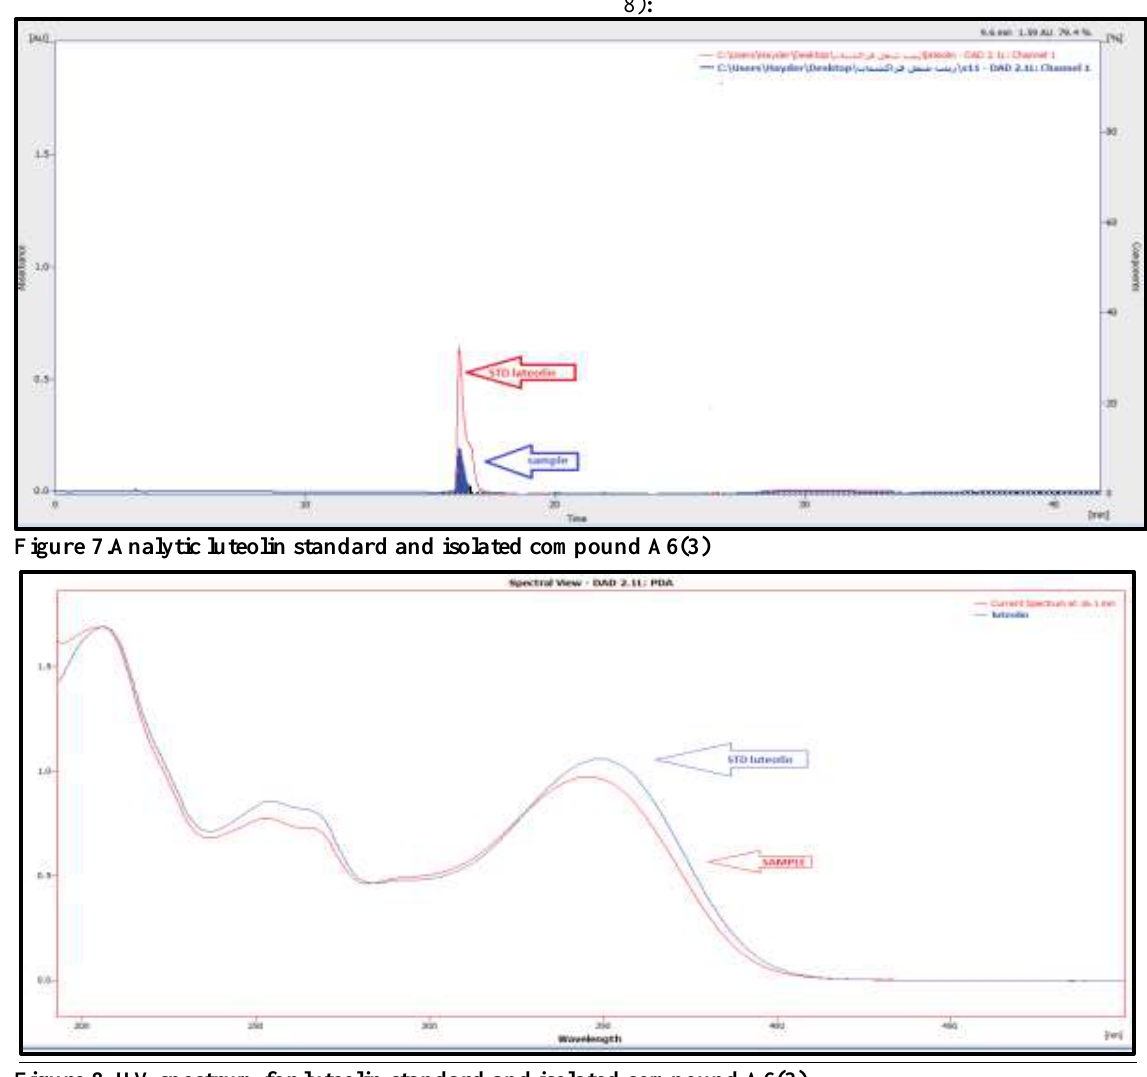
Figure 8. UV spectrum for luteolin standard and isolated compound